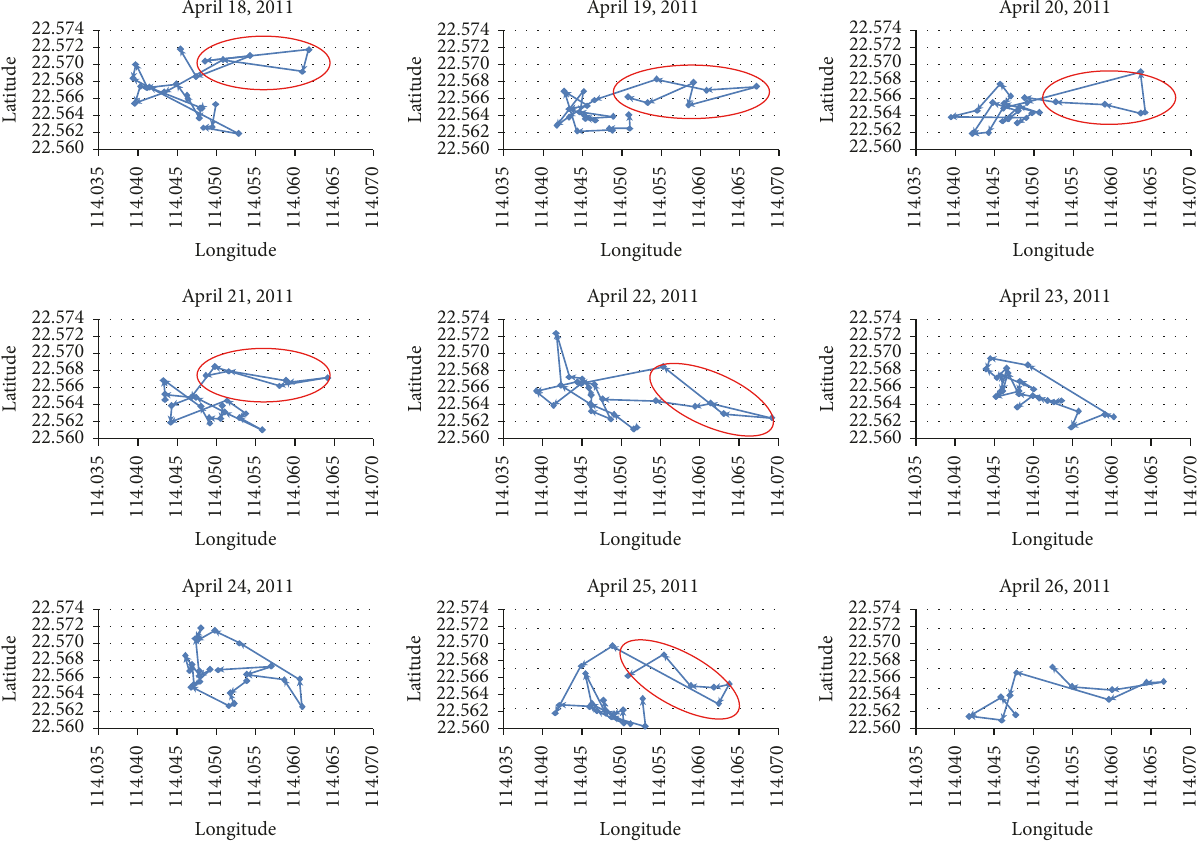
Figure 3: Spatial distribution of taxi driver’s pick-up activity space mean center (from Monday to next Tuesday). Table 4: Summary of each taxi vehicle’s service frequency of each